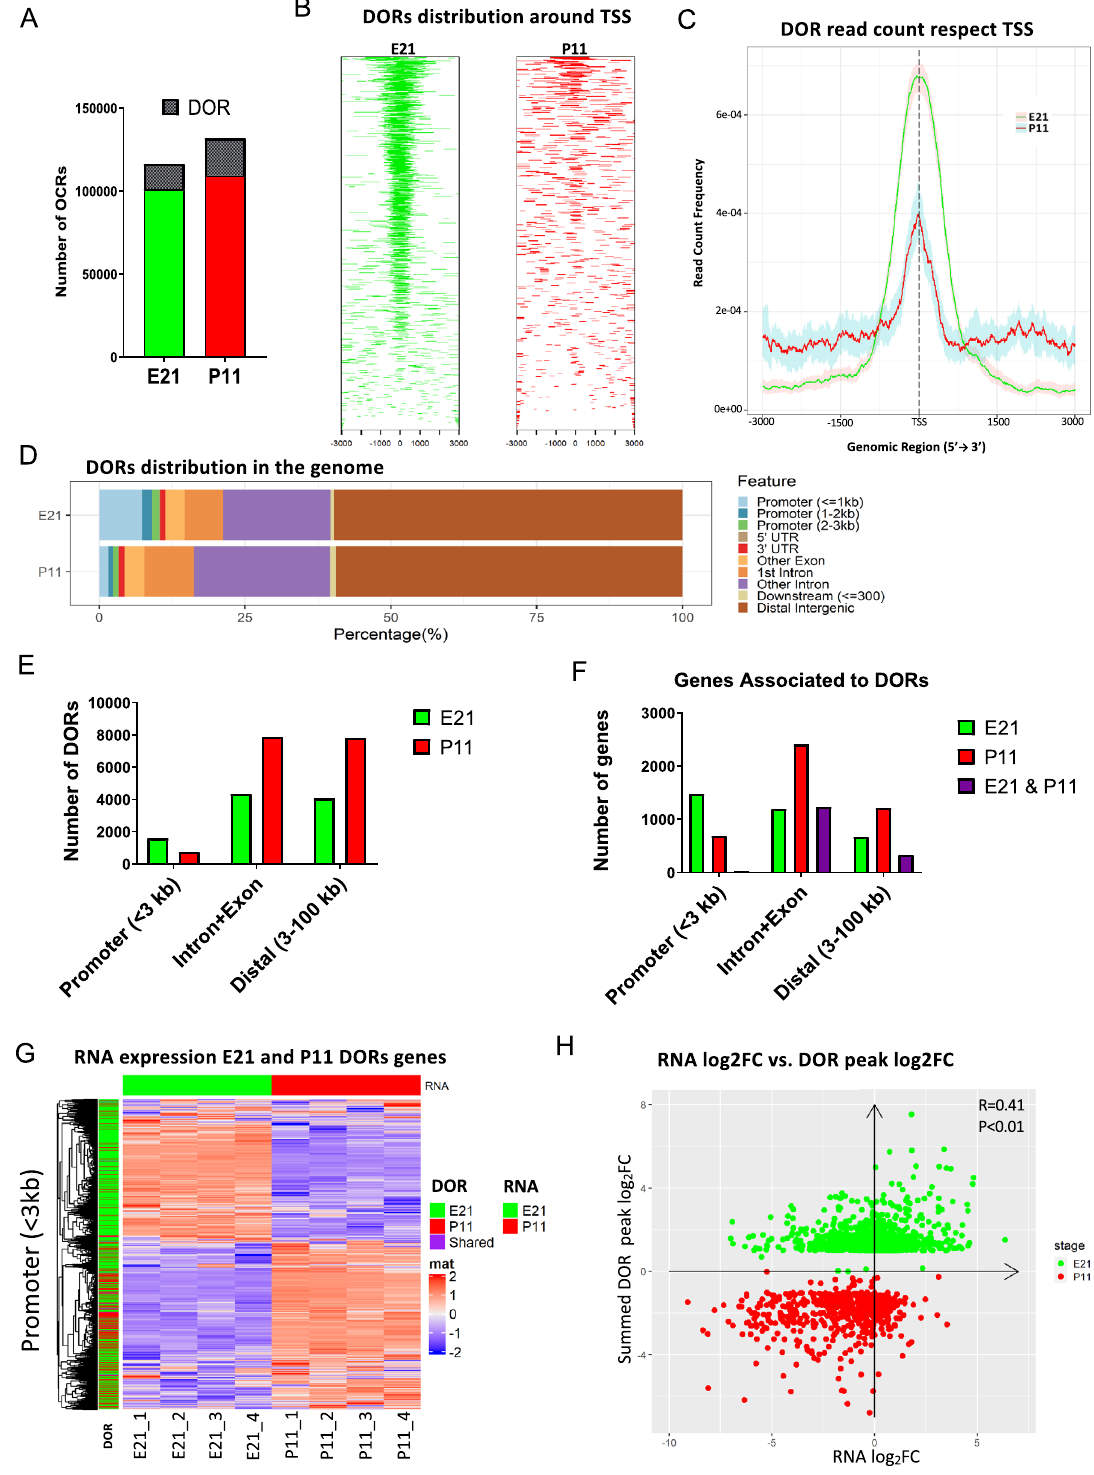
Figure 3. Differentially open regions (DORs) are preferentially located at the promoter region of E21 genes and correlate with RNA gene expression changes. (A) The number of OCRs that were present in both samples of each developmental stage and the number of DORs (cross-hatched area) obtained using DESeq2 69 implemented in the ATAC-seq Integrative Analysis Package (AIAP) package with default parameters. (B) Distribution of DORs with respect the closest gene TSS. (C) Read count frequency of DORs with respect to TSS. (D) Distribution of DORs in the different regions of the genome. (E) Number of DORs at the promoter region (< 3 kb from TSS), distal region (> 3 kb but < 100 kb from TSS), and genic (intron + exon) region. (F) Genes associated with DORs present at the promoter, distal, and genic region. (G) RNA expression changes at E21 and P11 in relation to the presence of DORs at the promoter region. Each row represents a gene that is associated with only E21 DORs (green), only P11 DORs (red), or both E21 and P11 DORs (purple). (H) Pearson correlation coefficient (p < 0.01) of log2 fold changes in gene expression between E21 and P11 and log2 fold changes in peak signal of DORs that are located in the promoter